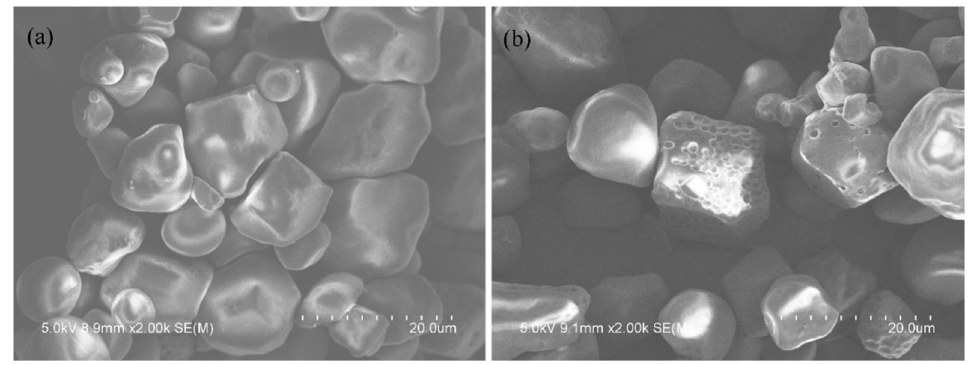
Figure 2. SEM images of ACS ( a ) and HCS ( b ).